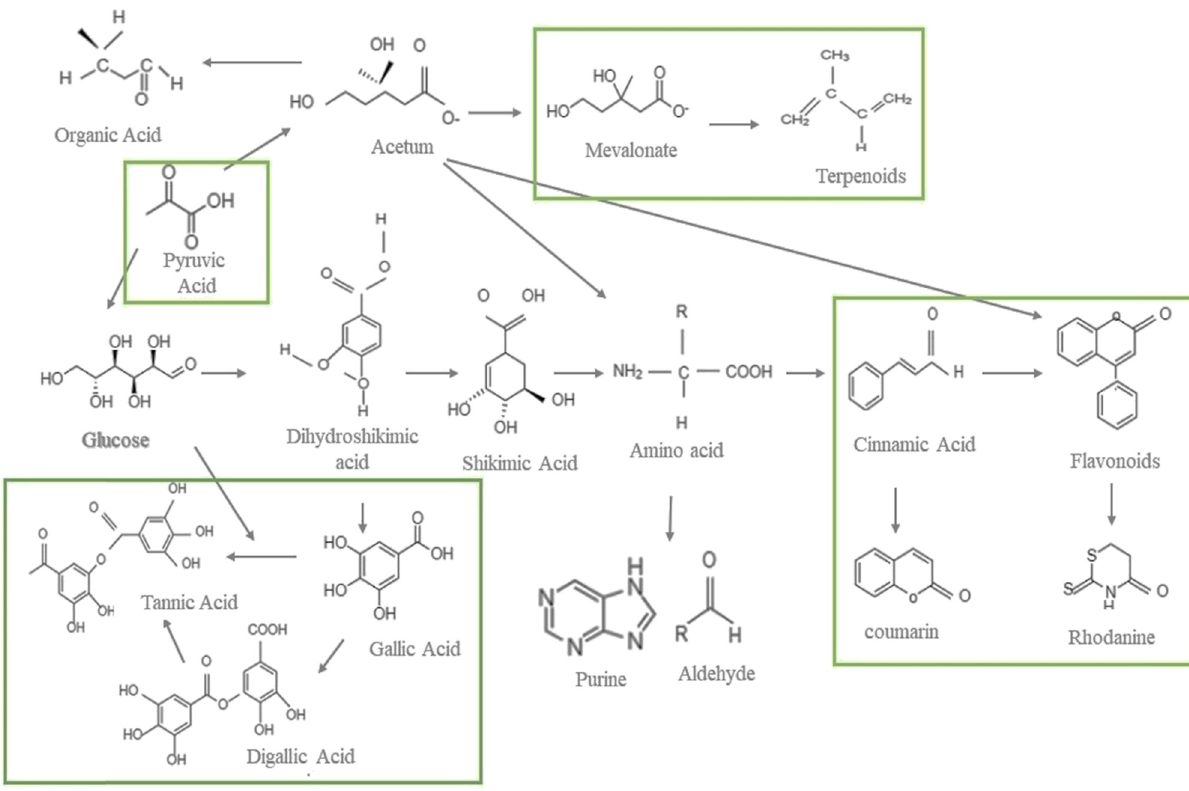
Figure 3: Biosynthetic pathways of major allelopathic substances [ 6 ] .